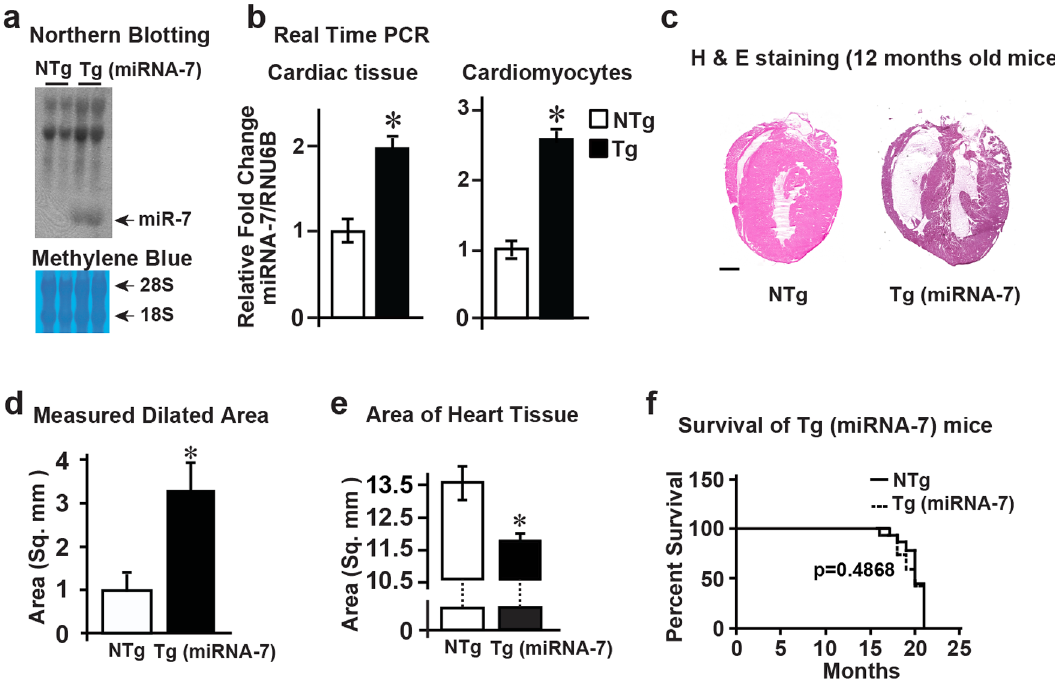
Figure 1. microRNA-7 (miRNA-7) Tg mice have similar life span despite cardiac dilation ( a ) Northern blotting for miRNA-7 in the Tg (miRNA-7) mice and littermate controls (NTg) (upper panel); Methylene blue staining of RNA for equal loading (lower panel) (n = 5). ( b ) Real time PCR analysis for miRNA-7 expression from cardiac tissue (left panel) and isolated adult cardiomyocytes (right panel) from NTg and Tg mice. * p < 001 vs. NTg (n = 5). ( c ) Cardiac sections from 12 month old NTg and Tg mice stained with H & E wherein, Tg hearts are characterized by marked dilation compared to NTg (n = 4). Scale bar 1000 µm. ( d and e ) The dilated area ( d ) and the area of cardiac tissue ( e ) was measured with Image Pro Plus using the 12 month old H & E stained heart sections (n = 4). * p < 001 vs. NTg (d) & * p < 0.01 vs. NTg ( e ). ( f ) Kaplan–Meier survival curves for NTg and Tg mice show no appreciable differences in survival between NTg and Tg (n =